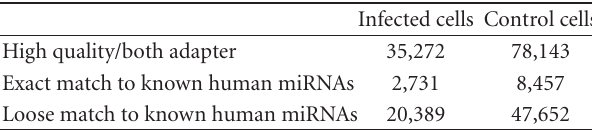
Table 1: Number of reads of miRNAs from EV71 infected and non- infected Hep2